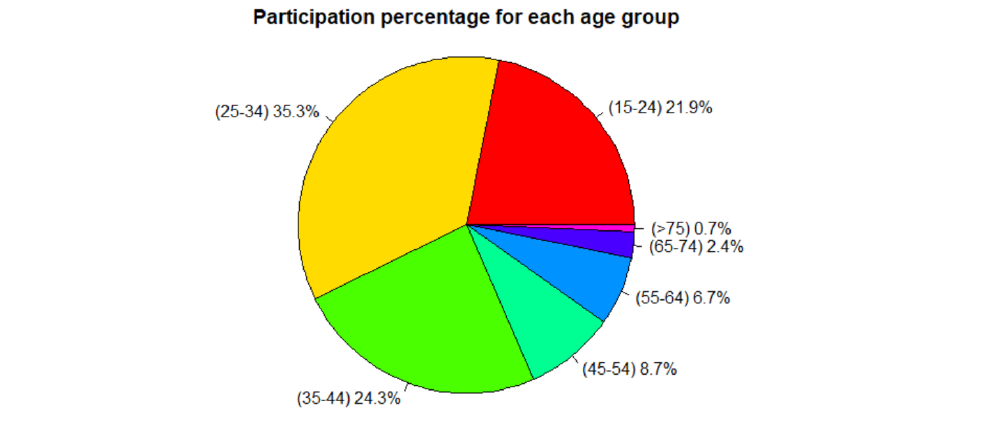
Figure 2. Study Area: Number of participants according to their